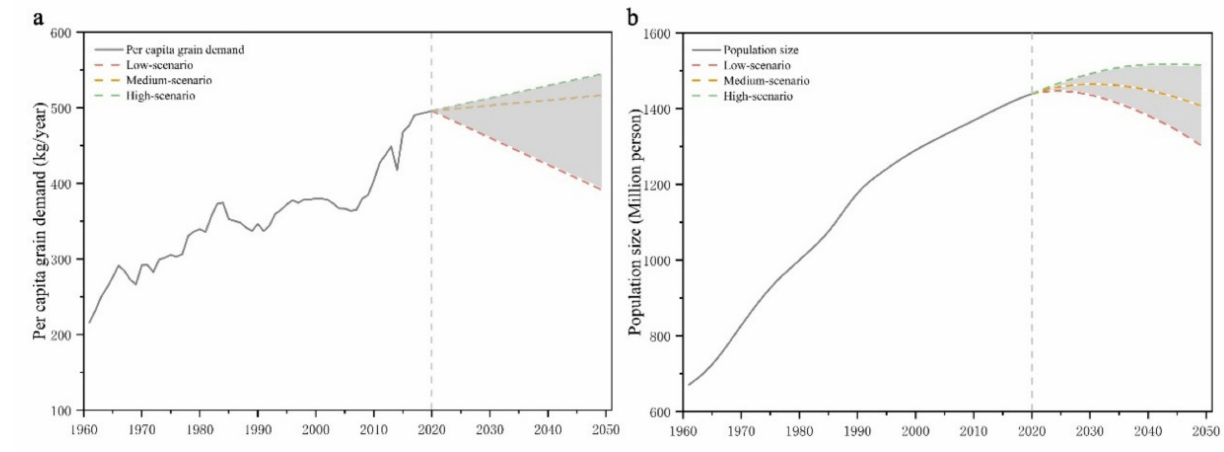
Figure 3. Scenarios of per capita grain demand ( a ) and population size ( b ) during 2020–2050.